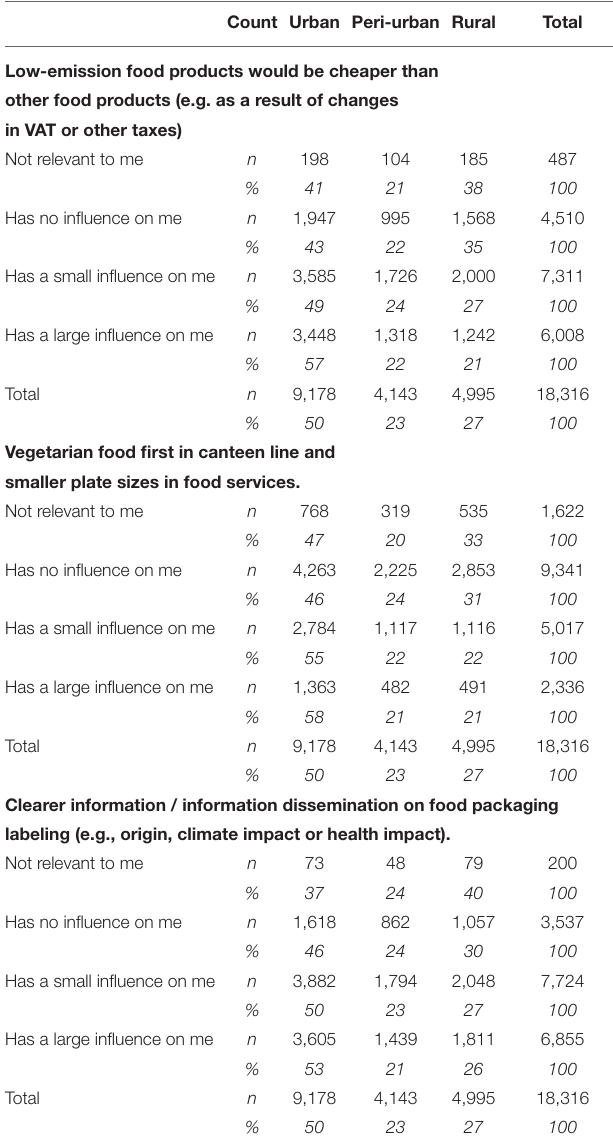
TABLE 1 | Frequency table to the question “How much would the policy option impact your food choices?” in different spatial contexts. Count Urban Peri-urban